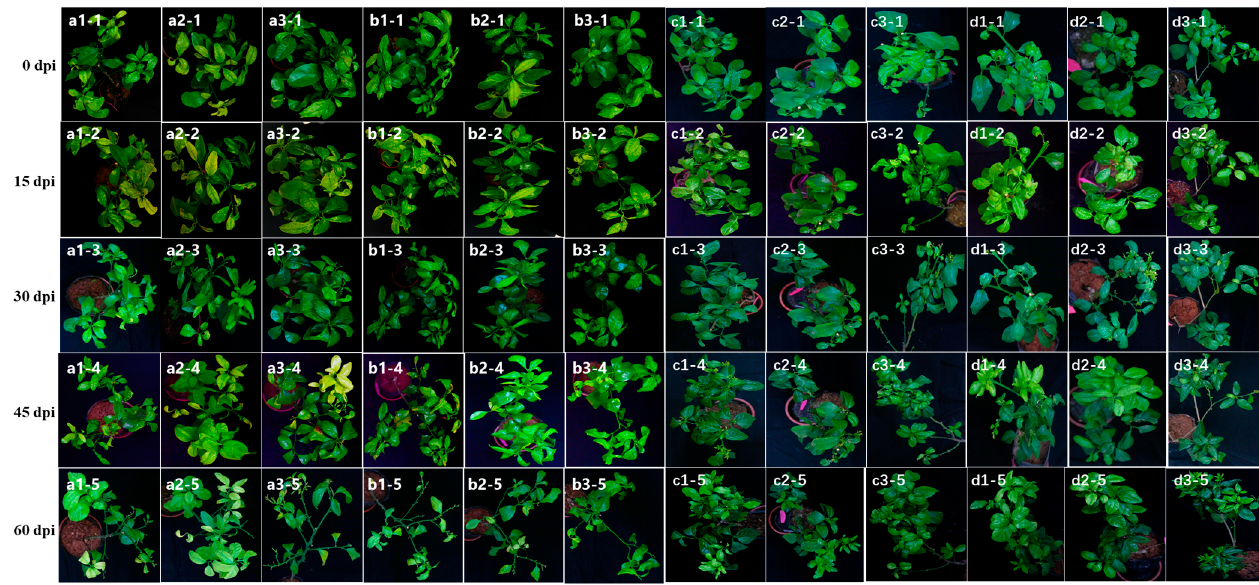
Orchard numbers are the same as those in Table 1. Egg, 1st, 2nd, 3rd, 4th, 5th, and Adult indicate the developmental stages of Egg, 1st instar nymph, 2nd instar nymph, 3rd instar nymph, 4th instar nymph, 5th instar nymph, and adult, respectively.